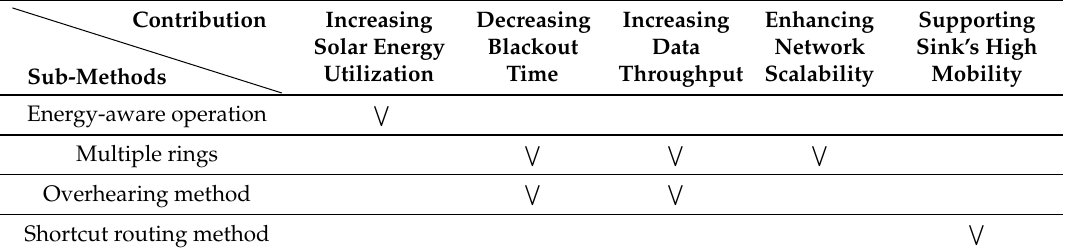
Table 1. Contribution by sub-methods of MRR